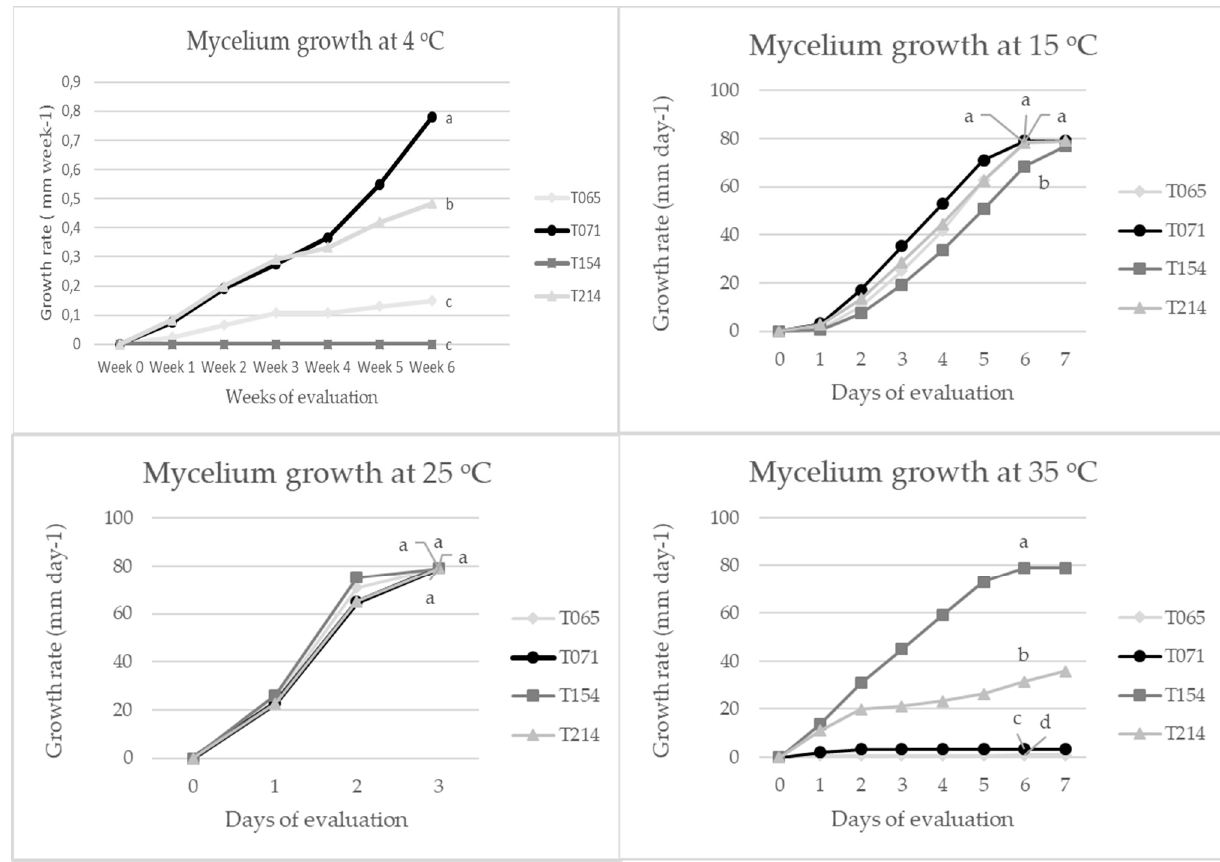
Figure 2. Evaluation of the growth of the Trichoderma strains at a different range of temperature (4 °C, 15 °C, 25 °C, and 35 °C). Values in each graph followed by the same letter do not differ significantly ( p = 0.05).